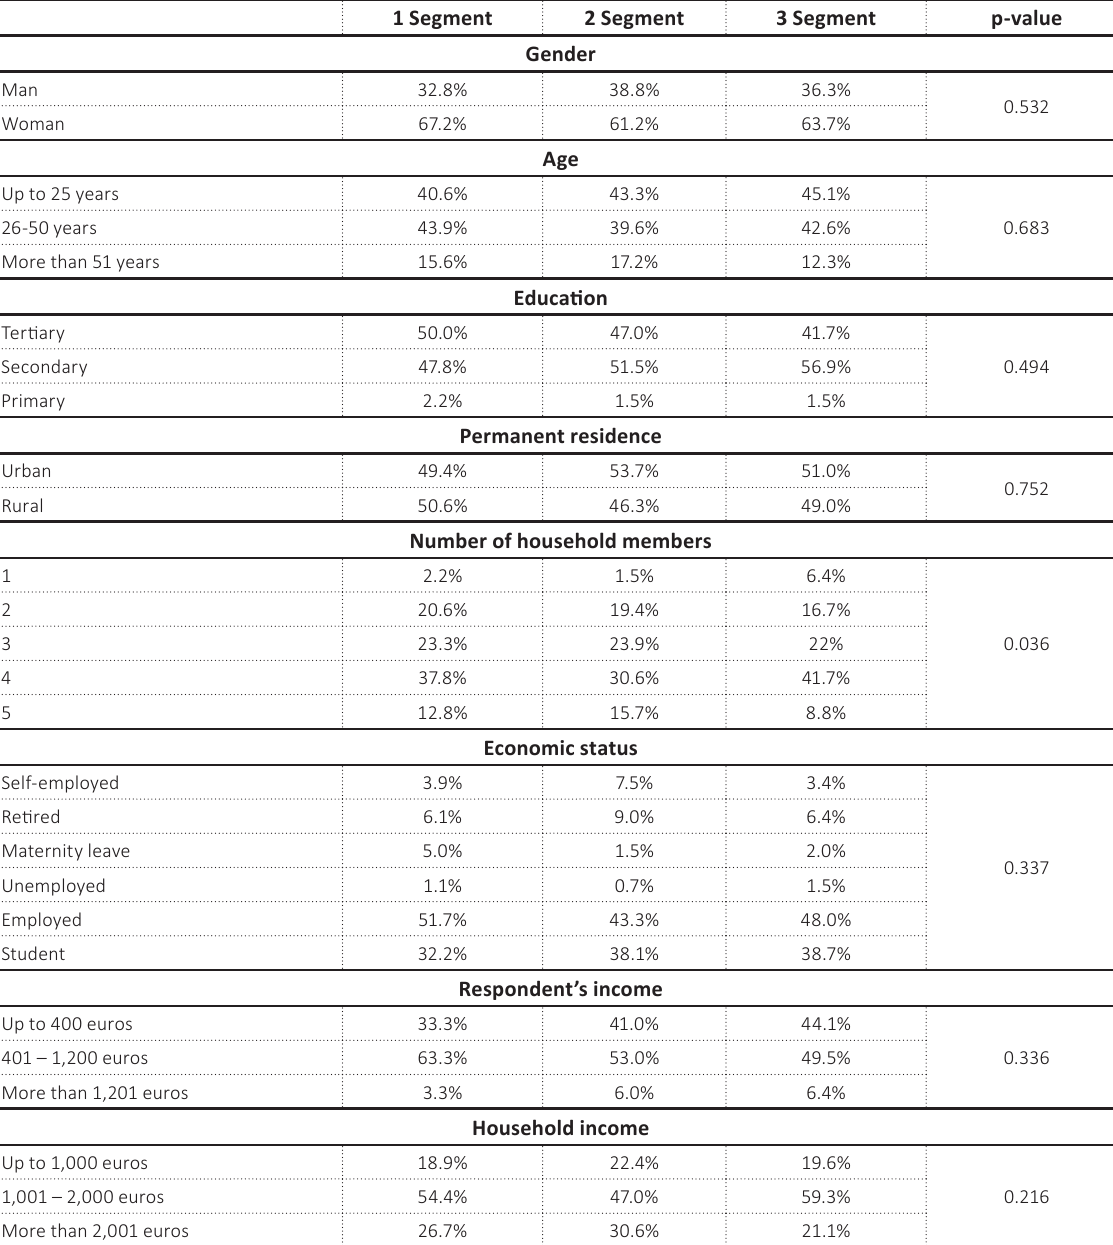
Source: Authors’ elaboration.